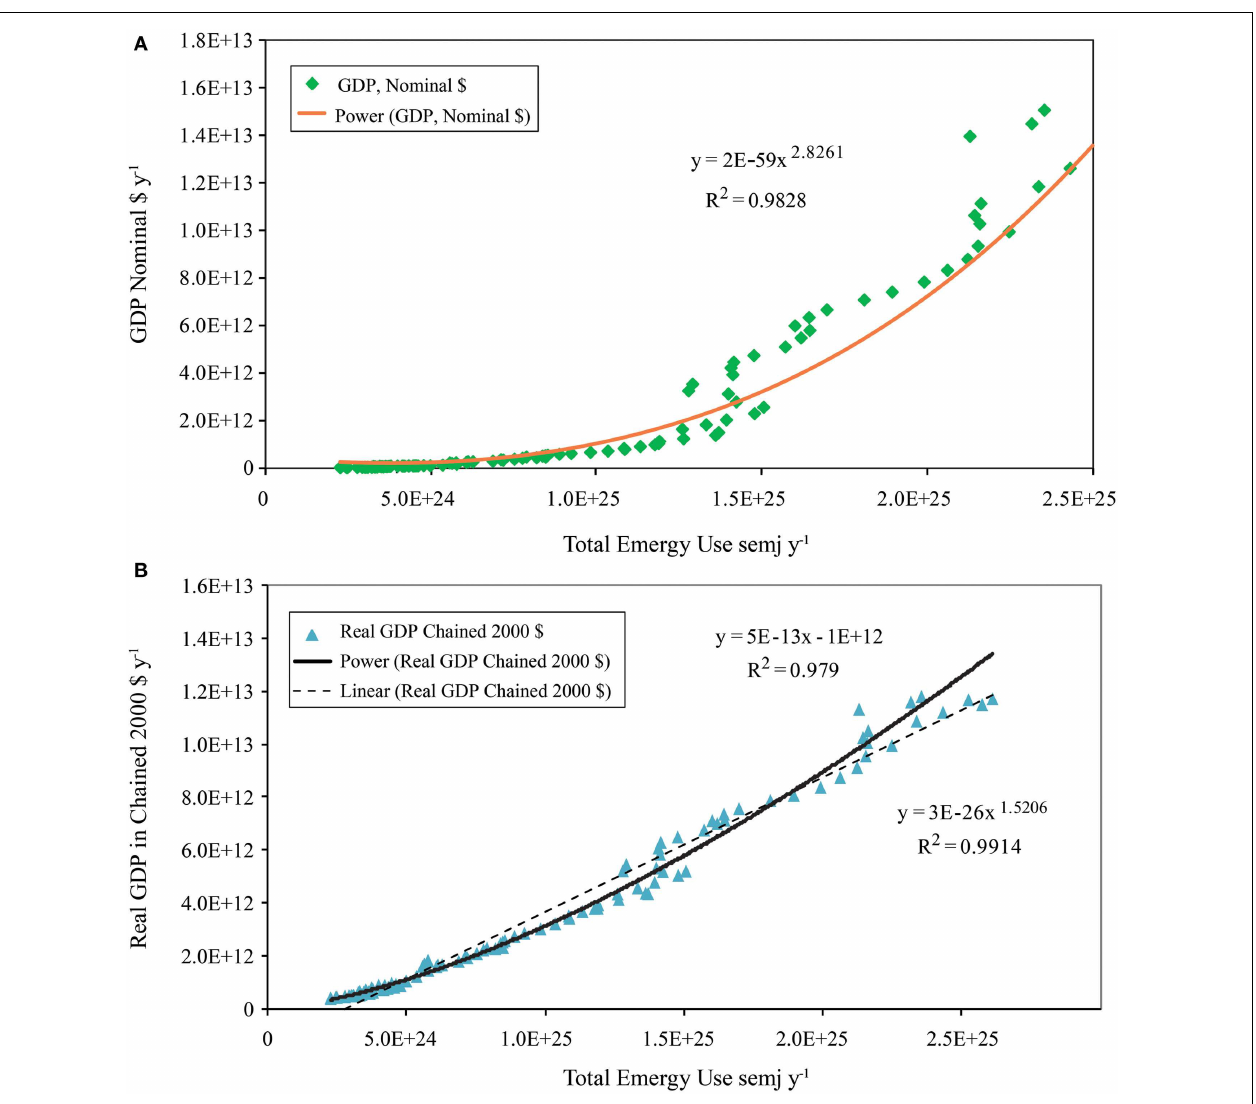
nominal GDP in Figure 12A . Calculations using the data for all measures of energy consumption including Emergy QA show the same pattern as a function of real GDP, i.e., after 1996 energy con- of real GDP